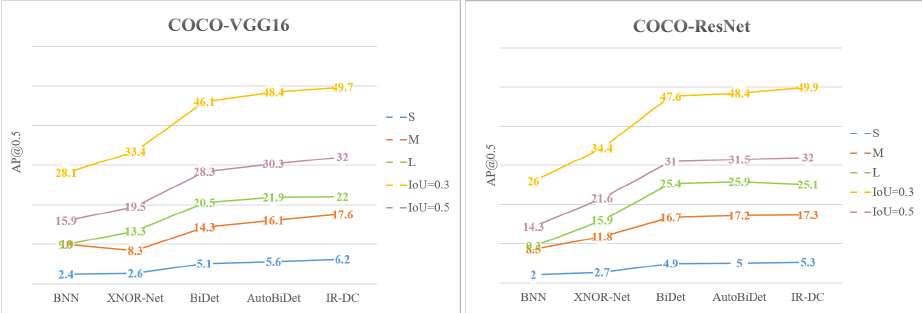
Figure 6. The results of different quantitative method in the COCO dataset.